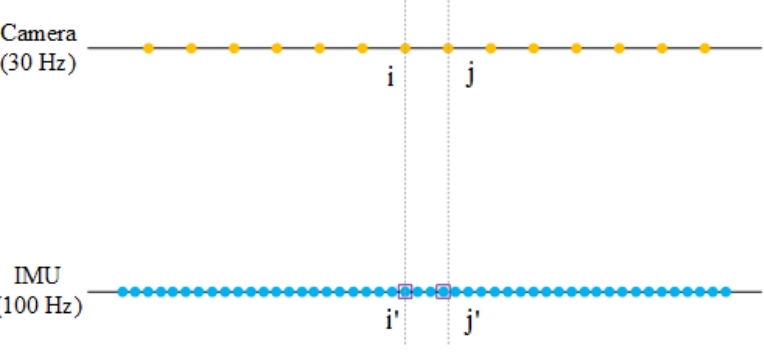
Figure 4. Architecture of the algorithm.